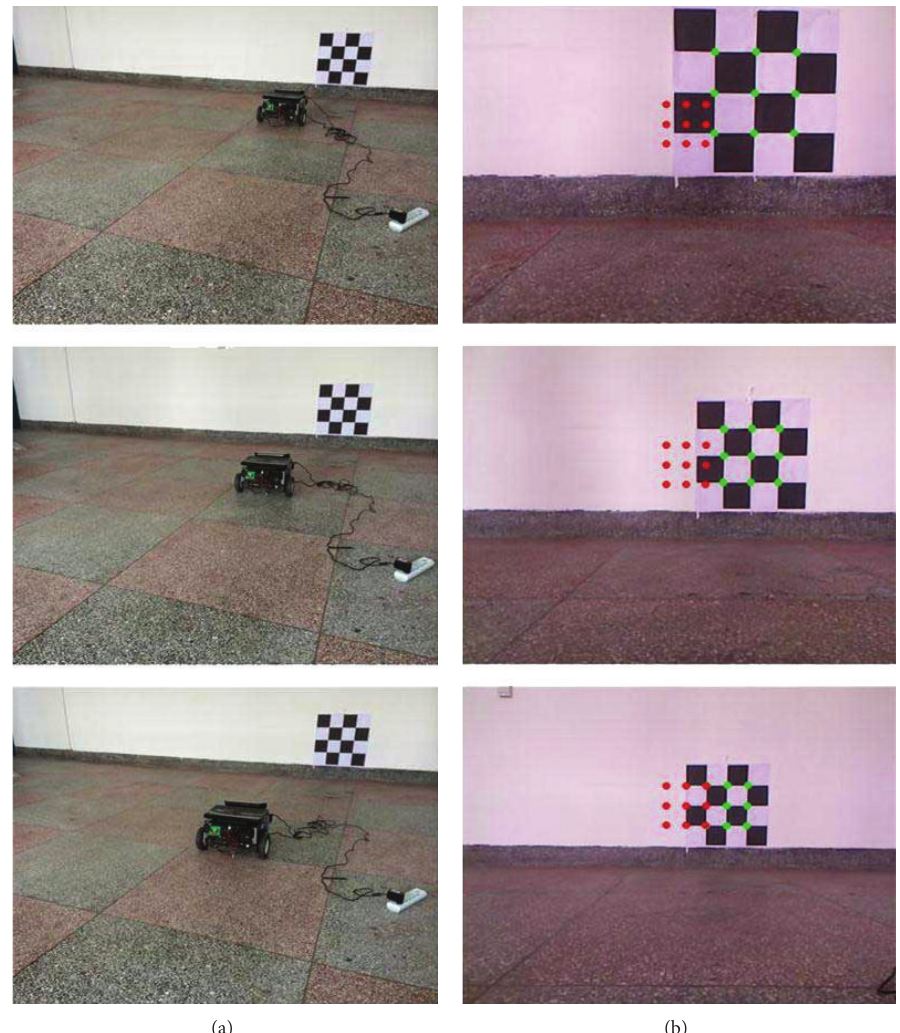
Figure 22: Experimental results. Snapshots of the robot motion (a) during the third step. Also, snapshots of the feature motion (b) superimposed on the current